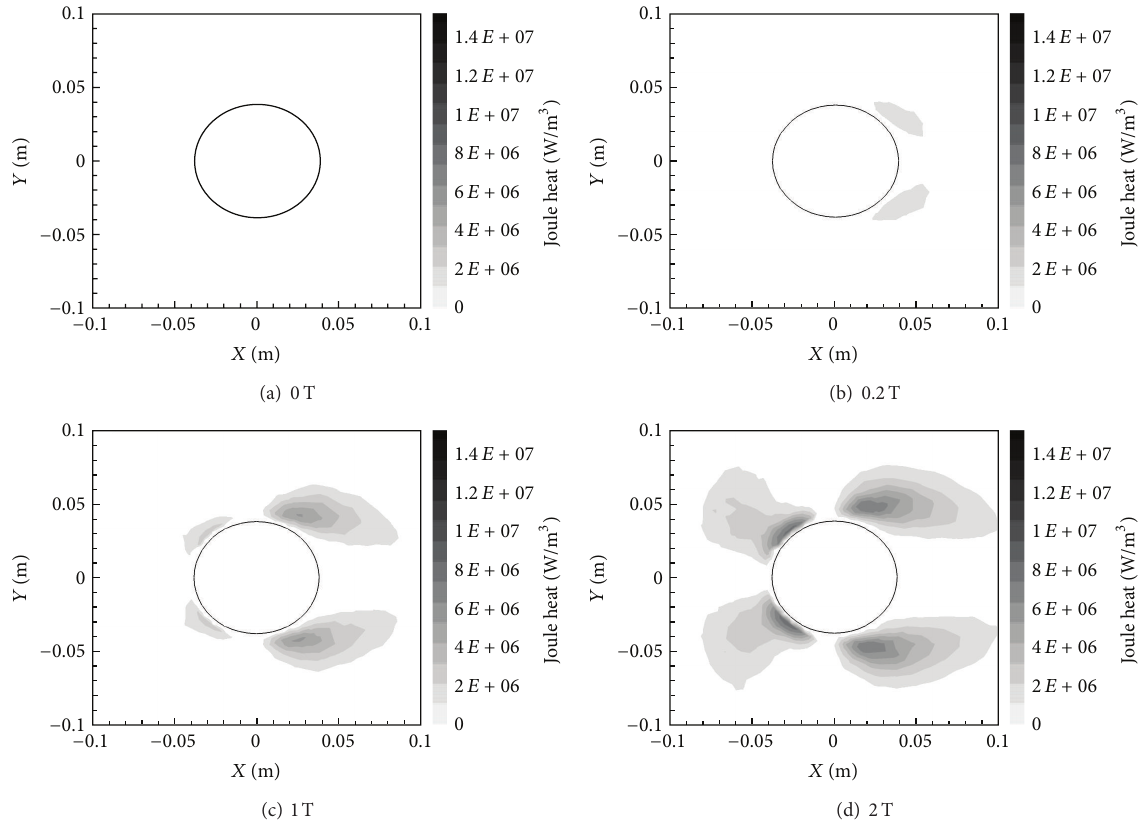
Figure 9: Joule heat contours for various 𝐵 max with 𝑋 -orientation.